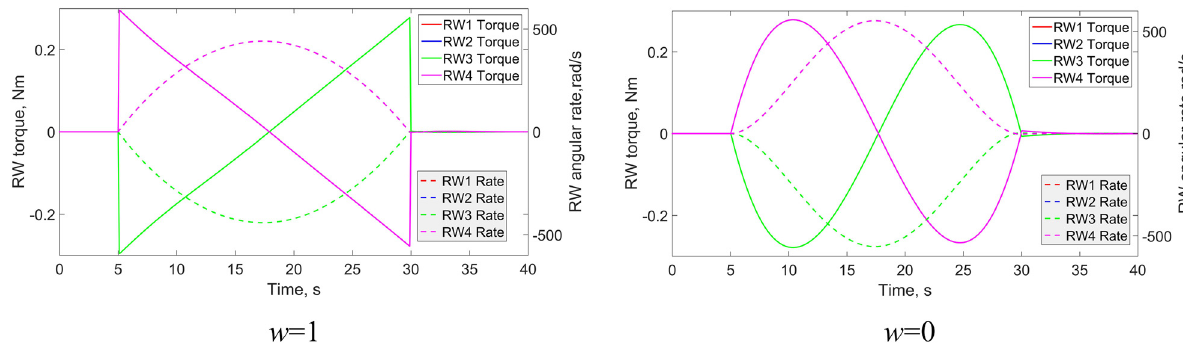
Figure 19: RW control torques and angular velocities for case 3.